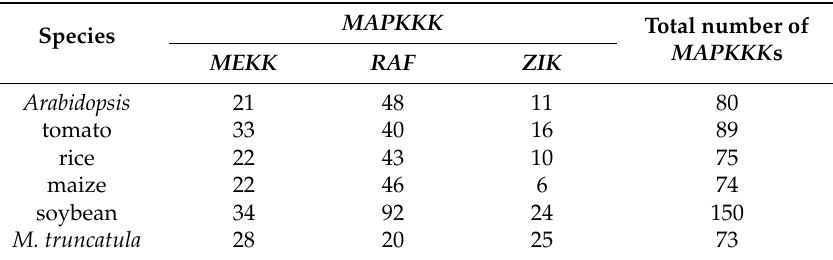
Table 3. The numbers of MAPKKK genes in plant